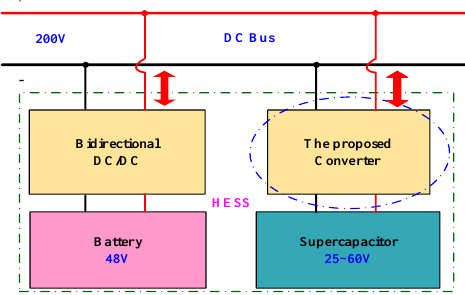
Figure 1. Configuration of the hybrid energy storage system (HESS). DC: direct current.